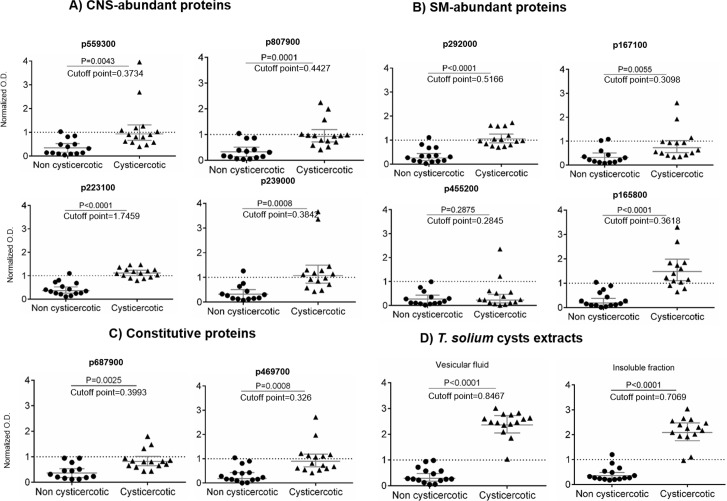
Taenia solium peptide recognition by cysticercotic and non cysticercotic pig sera through ELISA.A) Peptides from central nervous system, B) skeletal muscle abundant proteins, C) constitutive proteins and D) cysts protein extracts. Microtiter plates were coated with the peptides or extracts and incubated with sera from non cysticercotic (n = 15) and cysticercotic (n = 15) pigs, all bred in rural endemic areas. The normalized optical density (O.D.) is the result of dividing each individual O.D. by the cut-off value (mean value of non cysticercotic pigs plus two standard deviations). P-values are shown at the top of each figure.